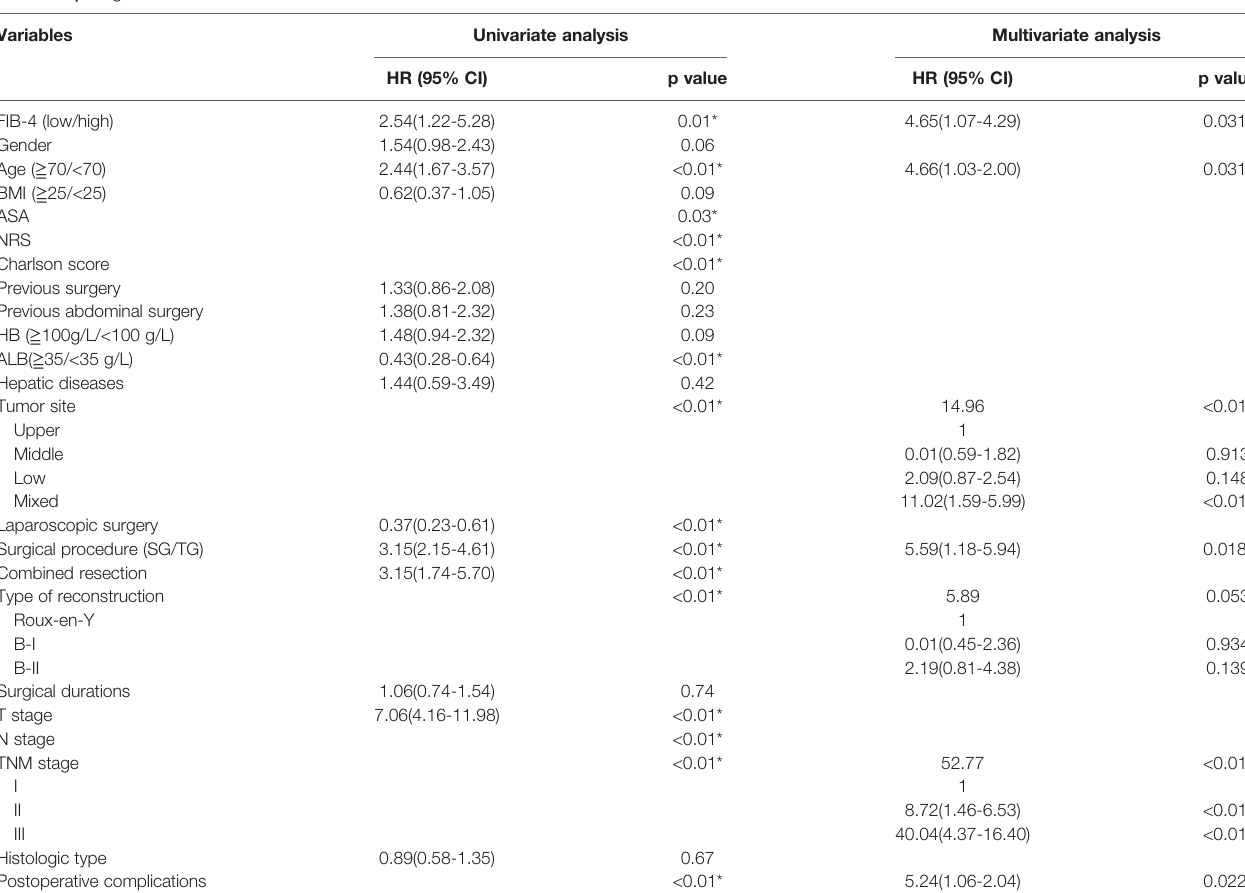
TABLE 2 | Prognostic factors for overall